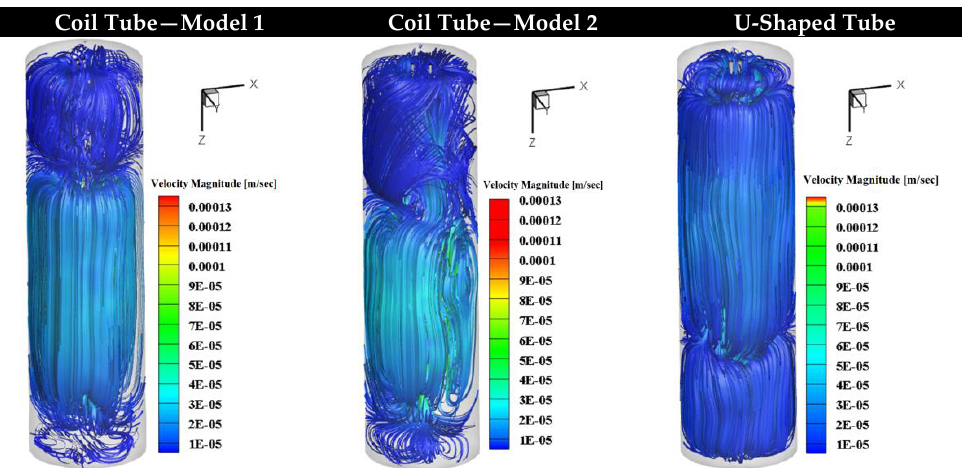
Figure 15. Three-dimensional streamlines with contours of the velocity magnitude for the three different cases in the horizontal position.